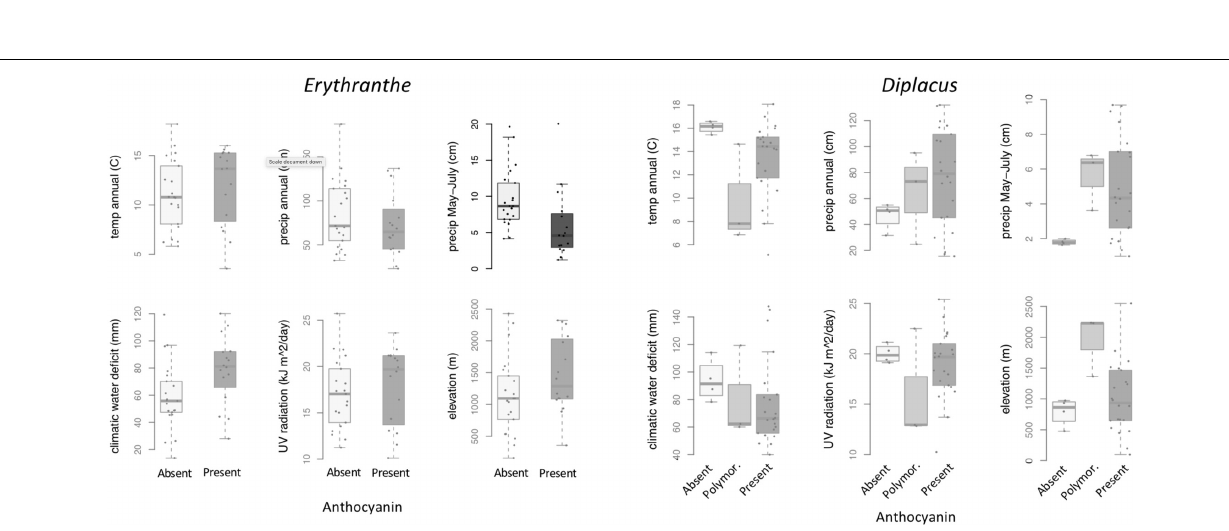
Frontiers in Plant Science |